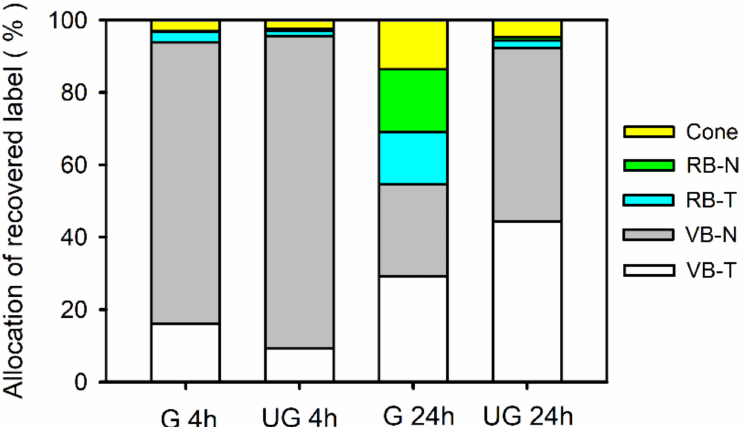
Figure 6. Allocation of 13 C photoassimilates throughout tissues (needles, twigs, and cones) of vegetative (VB) and reproductive (RB) branches after 4 h and 24 h of 13 C pulse labeling in VB of Pinus koraiensis . Each tandem of branches were girdled (G) or remained ungirdled (UG) ( n = 6). Mean values (%) are given relative to the total amount of label recovered across sampled tissues and branch types. Abbreviations: RB-N: Needles of reproductive branch; RB-T: Twig of reproductive branch; VB-N: Needles of vegetative branch; VB-T: Twig of vegetative